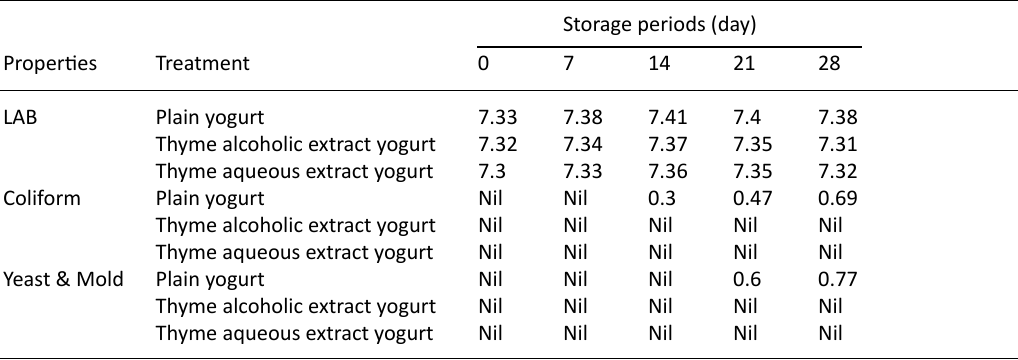
Table 2 . Microbial content of LAB, Coliform bacteria and yeast & mold log (cfu/ml) of (PY), (TCEY) and (TAEY) during storage